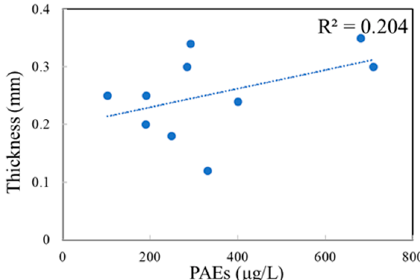
Figure 1. Correlations between the bottle thickness and amount of phthalate esters (PAEs) in polyethylene terephthalate (PET) bottles.